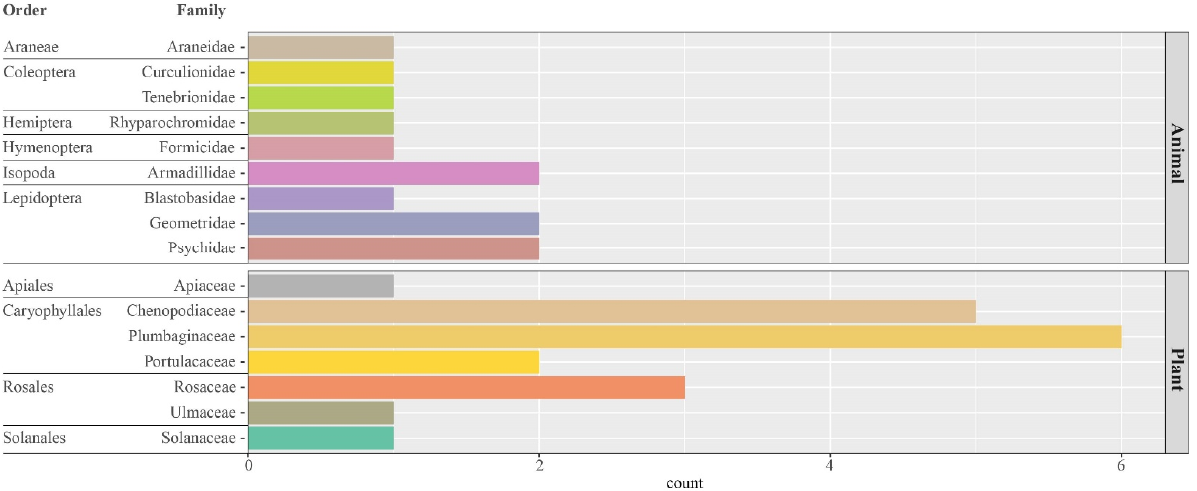
Figure 7. Frequencies of occurrence of each family of animals or plants as a qualitative indicator of diet composition of Podarcis liolepis from Grossa Island through molecular analysis. Table 2. List of identified diet taxa to the maximum resolution obtained in the diet composition of Podarcis liolepis from Columbretes Grossa through molecular analysis.